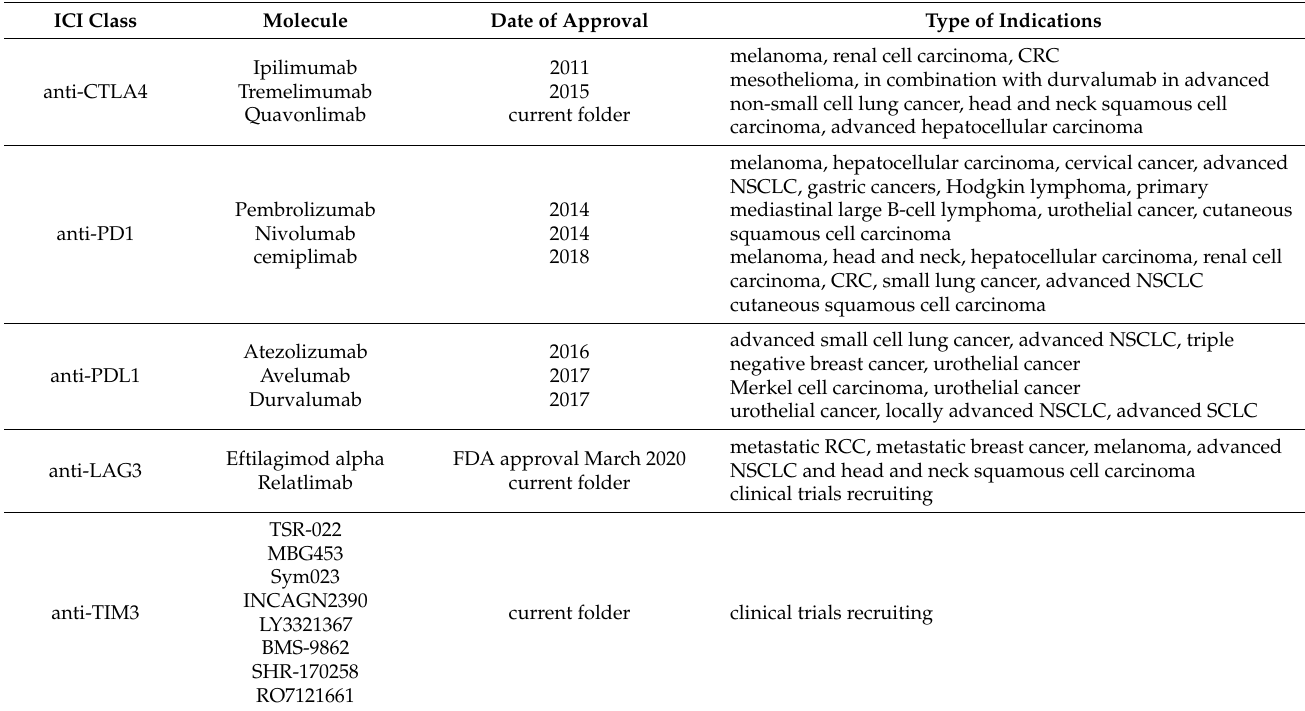
Table 1. ICI list with